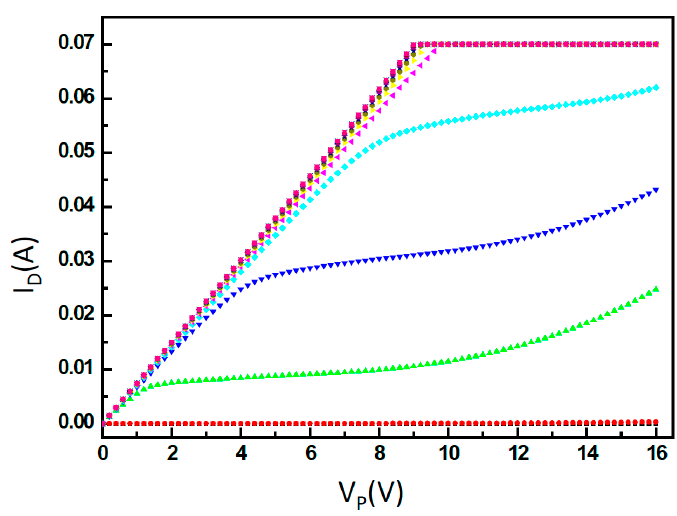
Figure 13. Current of drain versus the voltage of power (I D -V P ) of the metal-oxide-semiconductors (MOS) driver’s electrical signal (driver with heater).